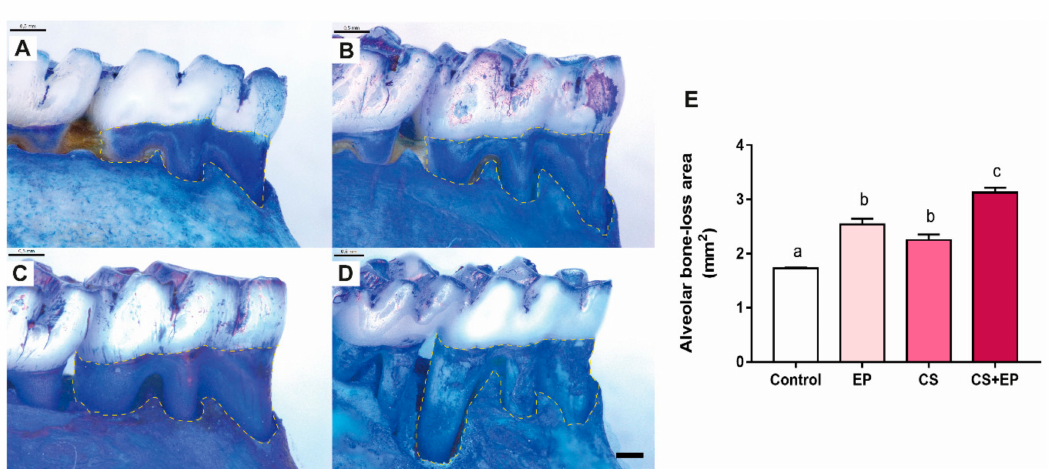
Figure 5. E ff ects of experimentally induced chronic immobilization stress and ligature-induced periodontitis on the alveolar bone of male Wistar rats (90-days-old, n = 28). Representative photomicrographs of hemimandibles of the ( A ) control group; ( B ) experimental periodontitis group (EP); ( C ) chronic stress group (CS), and ( D ) chronic stress and experimental periodontitis group (CS + EP). Results are expressed as mean ± standard error of the mean of ( E ) alveolar bone-loss area (highlighted in yellow). One-way ANOVA and Tukey’s post-hoc test, p < 0.05. Similar overwritten letters do not show statistically significant di ff erences. EP: ligature-induced experimental periodontitis group; CS: chronic stress by physical restraint model; CS + EP: association of chronic stress and ligature-induced periodontitis. Scale bar: 0.5